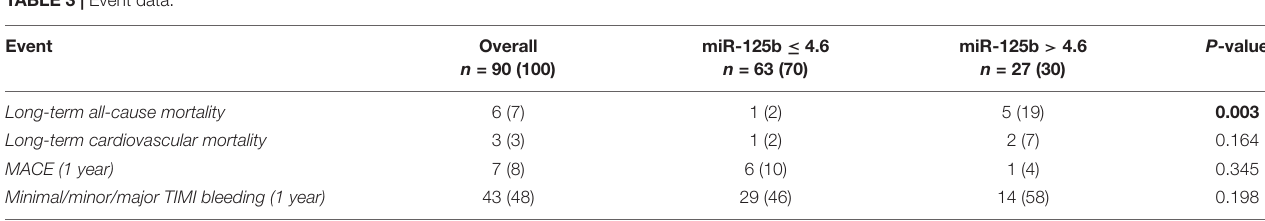
TABLE 3 | Event data.